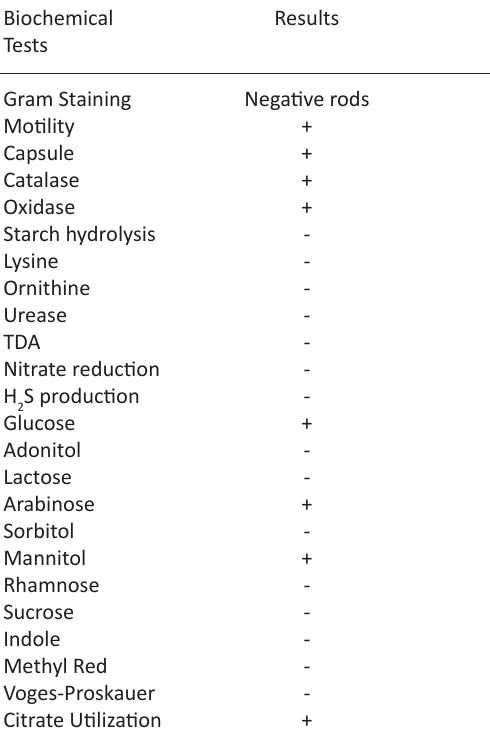
Table 1. Biochemical characterization of the Pseudomonas putida TS 18 Biochemical Results